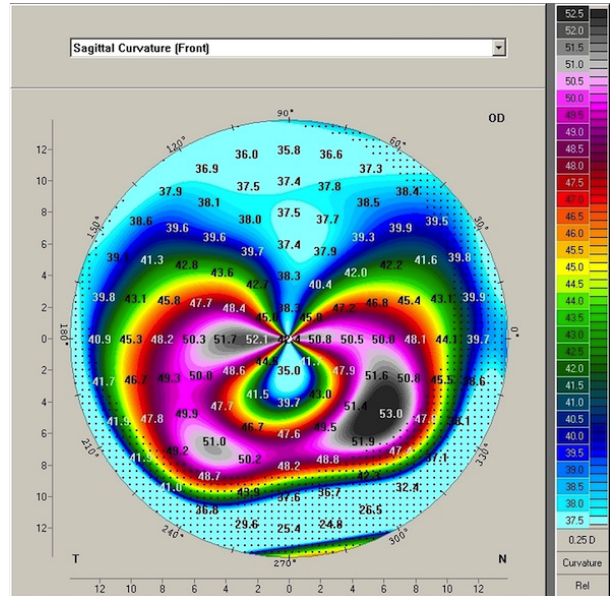
Figure 1. The crab claw or butterfly pattern on the anterior sagital curvature map. Notice the marked flattening of the cornea along the vertical meridian and the marked steepening of the inferior corneal periphery, which extends into the mid-peripheral inferior oblique corneal meridians associated with against-the-rule astigmatism.